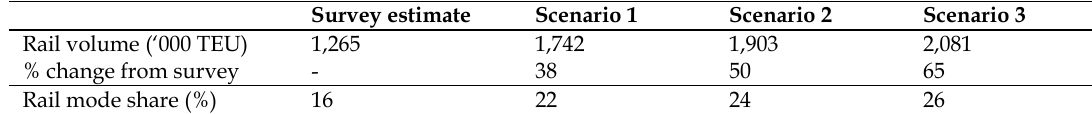
Table 7. Impacts of each scenario on rail volume and mode share